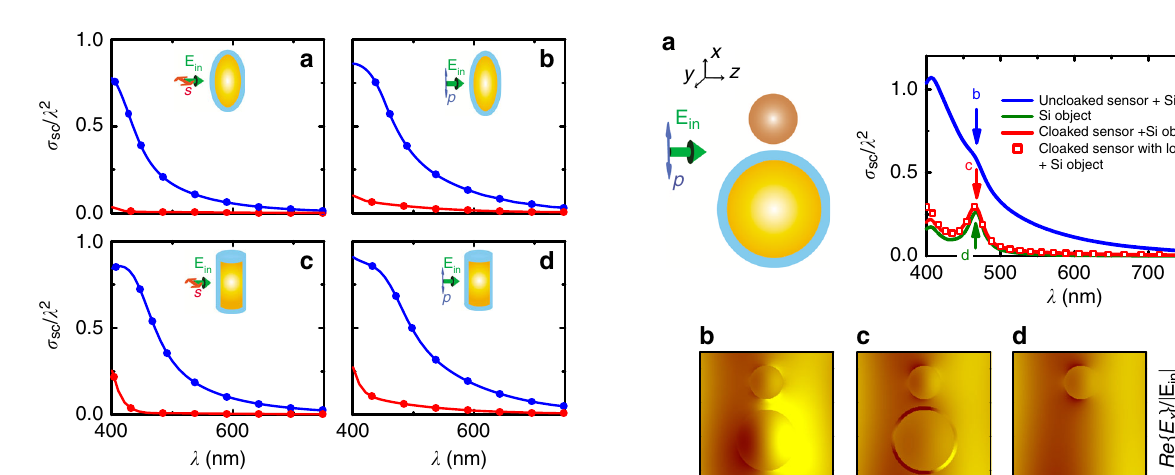
Fig. 3 Omni-polarization tachyonic cloaking of non-spherical 3D objects. Here, too, as in Fig. 2, the thickness of the cloak is, in all cases, only 10 nm, and inside it the average (dispersive) group velocity is ten times larger than the speed of light in vacuum ( 〈 v g 〉 ~10 c ) — i.e., the tachyoni c cloaks are similar to the one used for the spherical object in Fig. 2, without any additional customization or optimization. a Normalized scattering cross section of an uncloaked (blue line) and cloaked (red line) spheroid object, under s polarization of light as shown in the inset. b Normalized scattering cross section of the uncloaked (blue line) and cloaked (red line) spheroid object, under p polarization of light as shown in the inset. c Normalized scattering cross section of the uncloaked (blue line) and cloaked (red line) three-dimensional cylindrical object (of fi nite height), under s polarization of light as shown in the inset. d Normalized scattering cross section of the uncloaked (blue line) and cloaked (red line) cylindrical object, under p polarization of light as shown in the inset. Solid lines correspond to fi nite- element simulations, while the symbols correspond to integral-equation method solutions. Note in all cases the attainment of ultrabroadband, across-the-visible cloaking performance